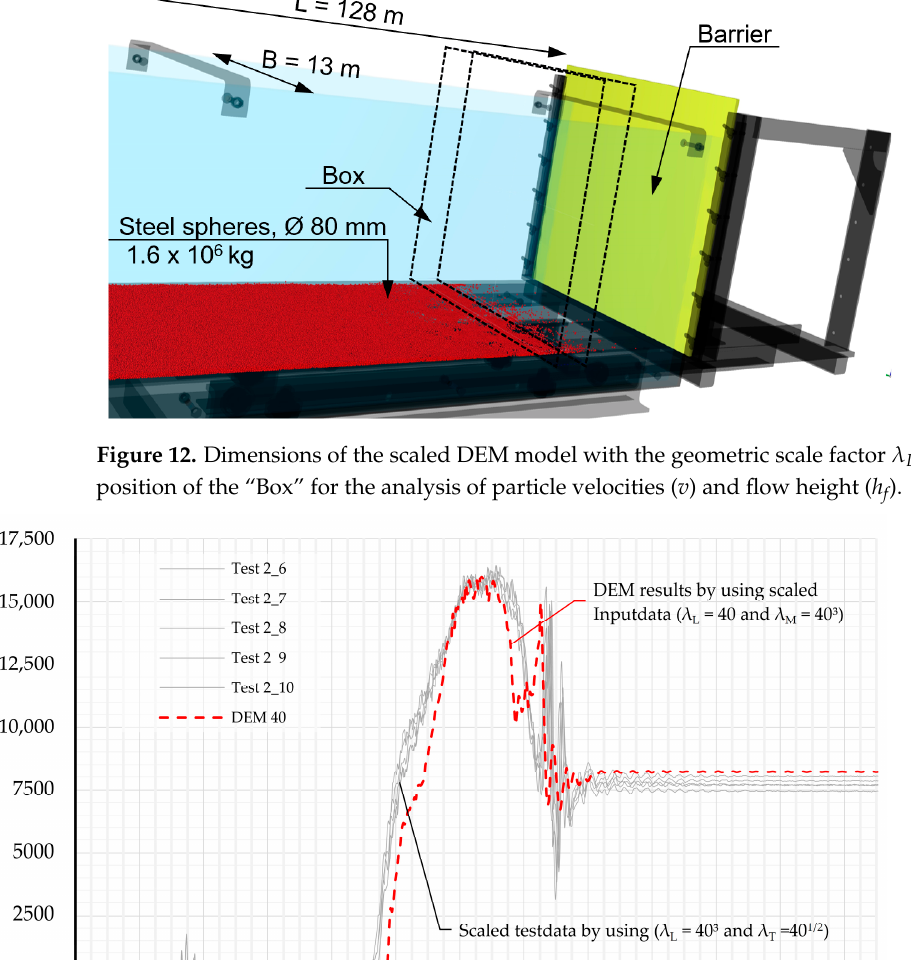
Figure 13. Force–time history of the impact on the rigid barrier, a comparison of the scaled test data